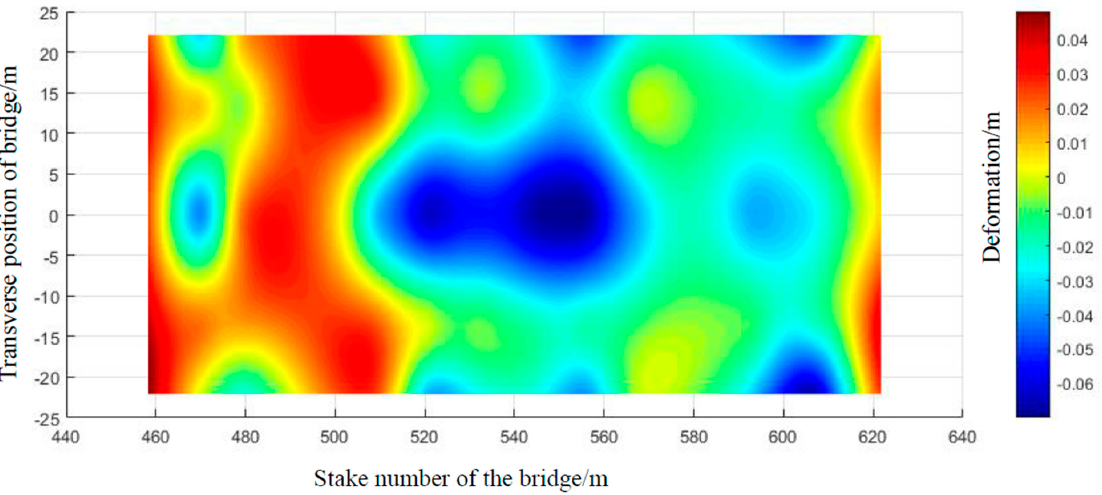
Figure 26. Deformation of the box girder after the demolition of the frame scaffolding (unit: m). Measurement time: 17:36–18:20 on 25 September 2019. Environmental temperature: 29 °C.